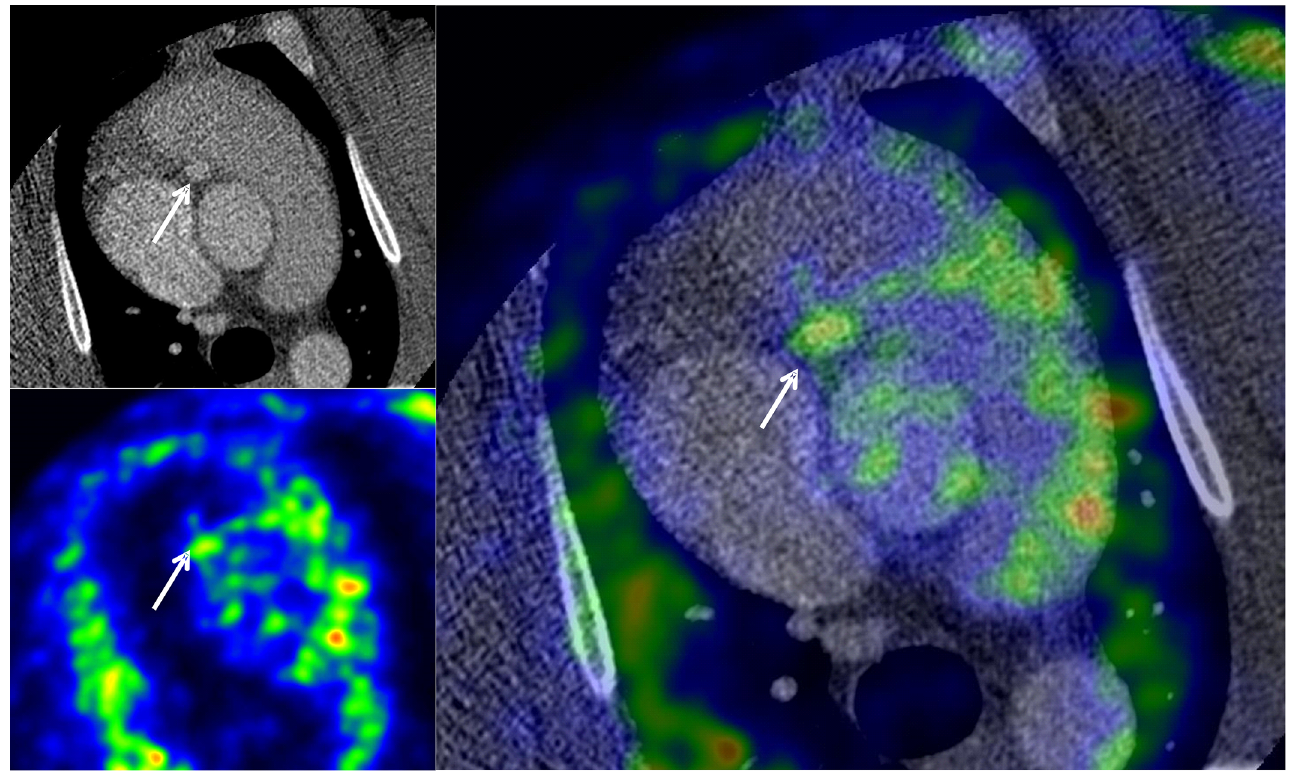
Fig 4. Representative example of fused axial coronary CTA and dual-gated [ 18 F]FDG PET images showing cross-section of the proximal right coronary artery (arrow) in an animal with atheroma. [ 18 F]FDG accumulation in the coronary arteries was measured using CTA as an anatomical